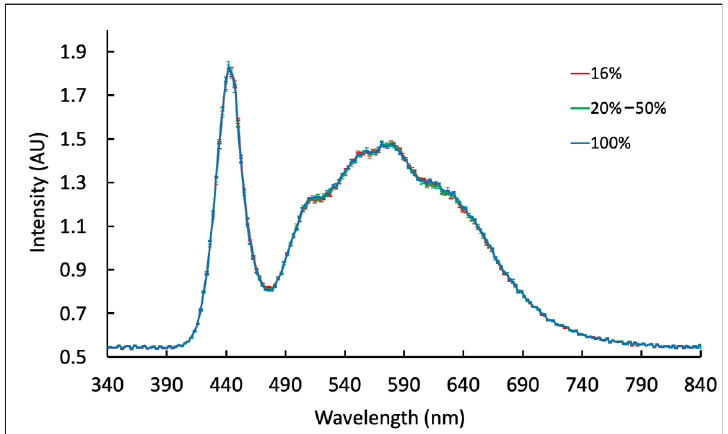
Figure 6. Flash spectrum variation of unplugged Samsung Note8 at various battery charge levels. The flash output was very consistent at various battery charge levels from 16% to 100%, with an average CV of 1.6% ± 0.4. Flash performance for battery levels below 16% was not measured due to Samsung software restrictions. Measurements were taken three times at each battery charge level on two Samsung Note 8′s.